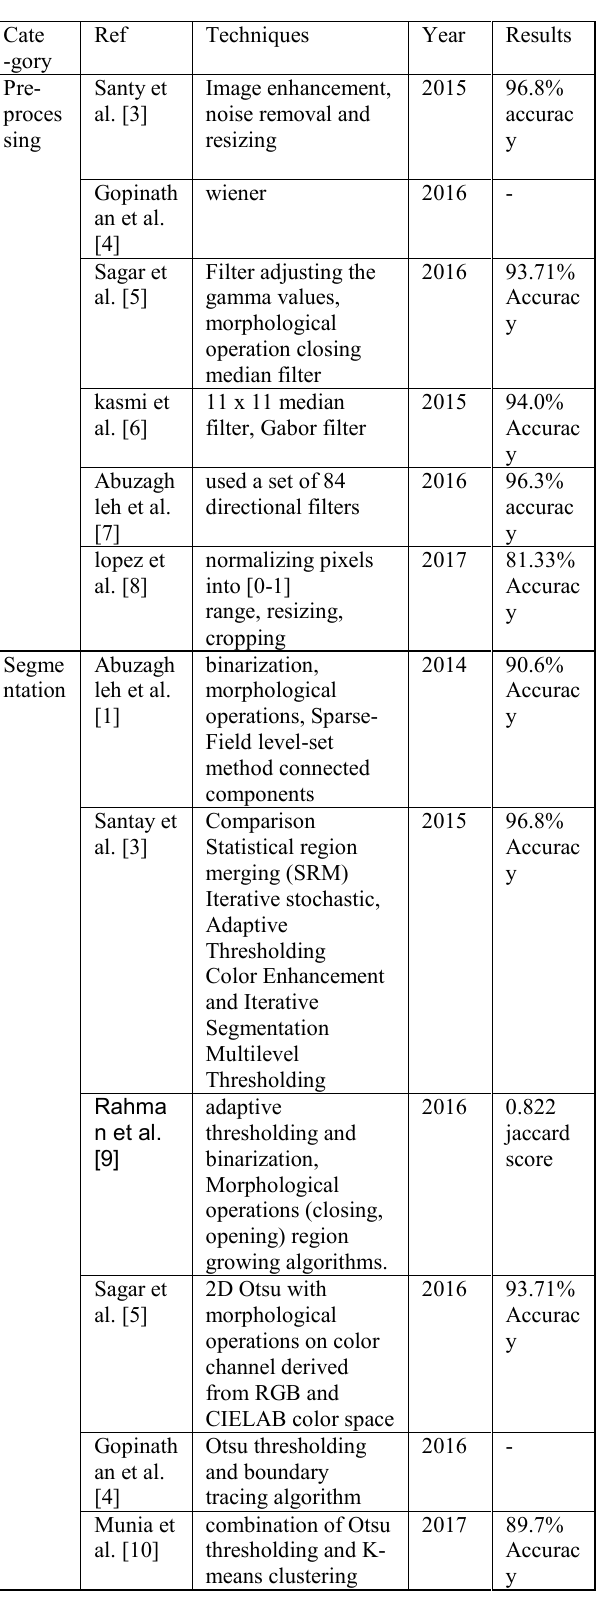
Table 1. Summary of literature work on skin cancer